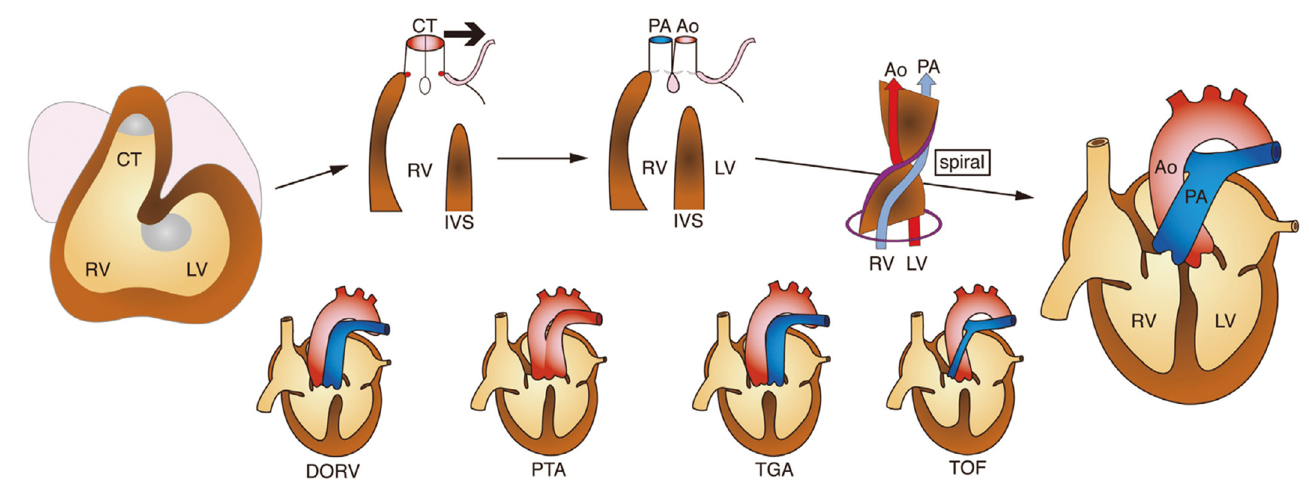
Figure 3. Normal development and congenital defects of the cardiac outflow tract. Based on devel- opmental and morphological studies, abnormalities in each step of the outflow tract development (upper figures) lead to the spectrum of congenital heart disease involving the outflow tract (lower figures). Bold arrow represents leftward movement of conotruncus (CT). RV: right ventricle, LV: left ventricle, IVS: interventricular septum, Ao: aorta, PA: pulmonary artery, DORV: double outlet right ventricle, PTA: persistent truncus arteriosus, TGA: transposition of the great arteries, and TOF: tetralogy of Fallot.